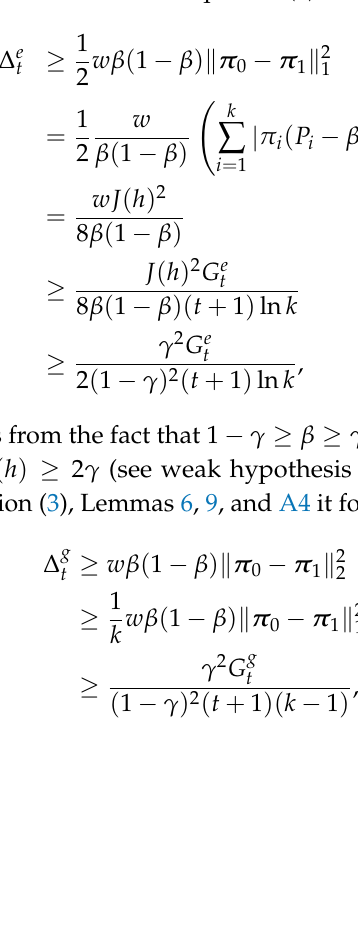
(cid:16) (cid:17)(cid:17) 1 ) ln / 1 1 − π 1